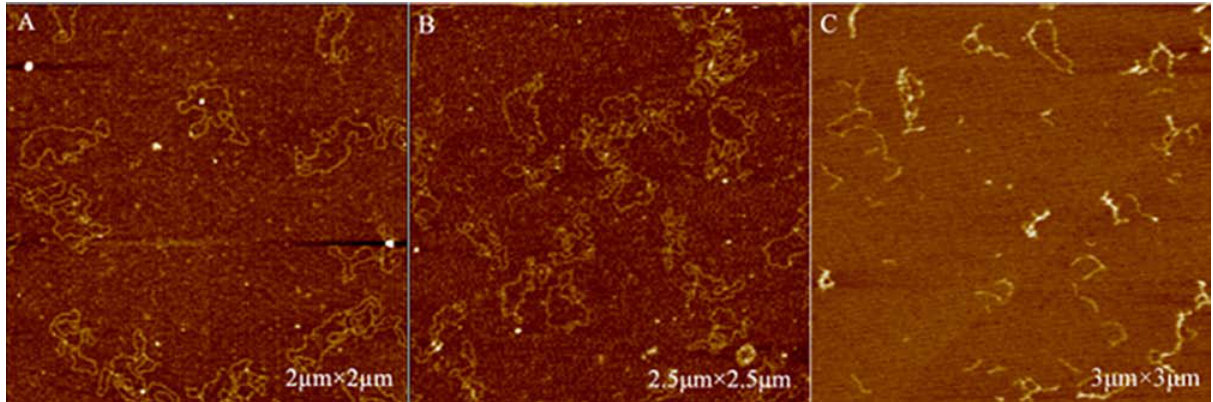
Figure 7. AFM imaging of pBR332 DNA plasmids treated with curcumin and/or Cu (II). A: Plasmid 0.05 µg plus 0.02 mM Cu (II) for 2 h; B: Plasmid 0.05 µg plus 0.02 mM curcumin for 2 h; C: Plasmid 0.05 µg plus 0.02 mM Cu (II) plus 0.02 mM curcumin for 2